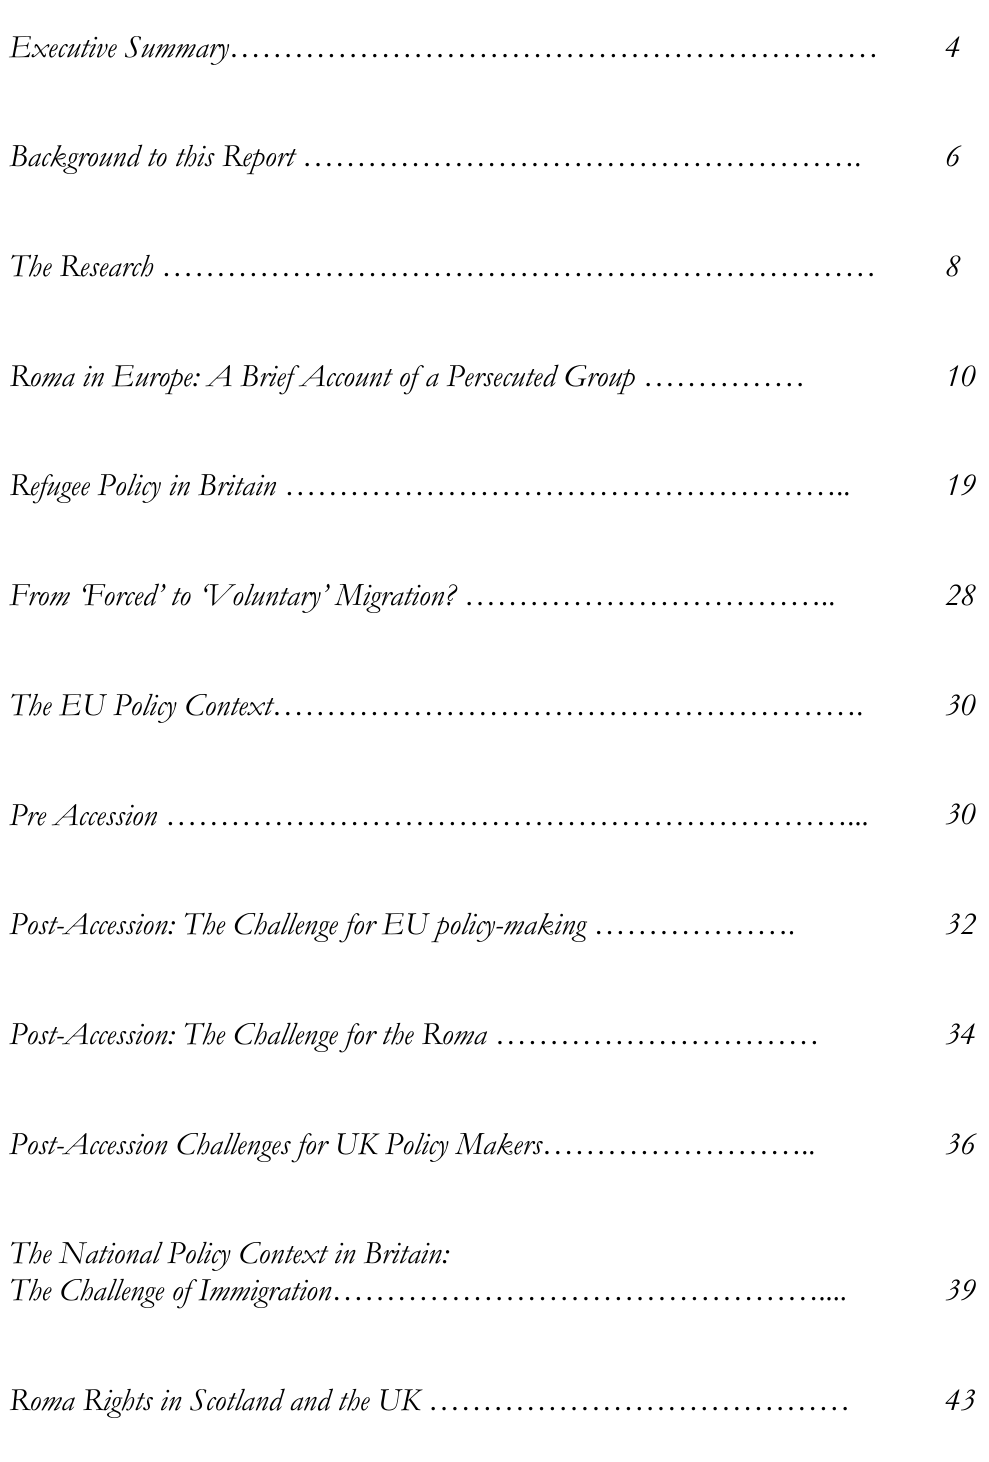
Table of Contents